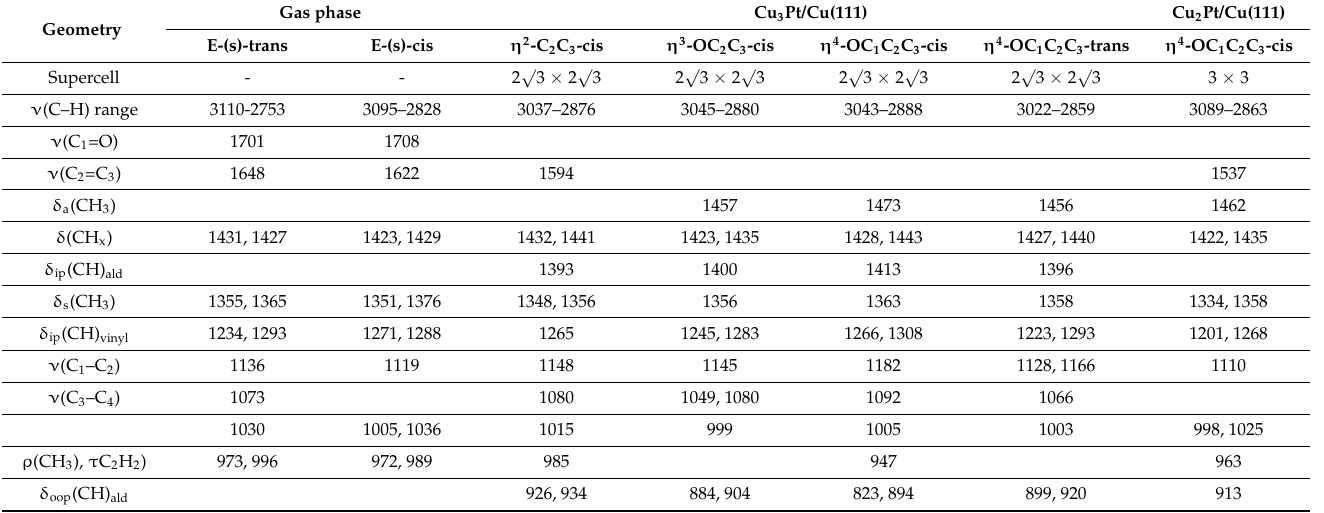
Table 3. Calculated vibrational frequencies (in cm − 1 ) for the E isomers of crotonaldehyde and for the five most stable adsorption configurations